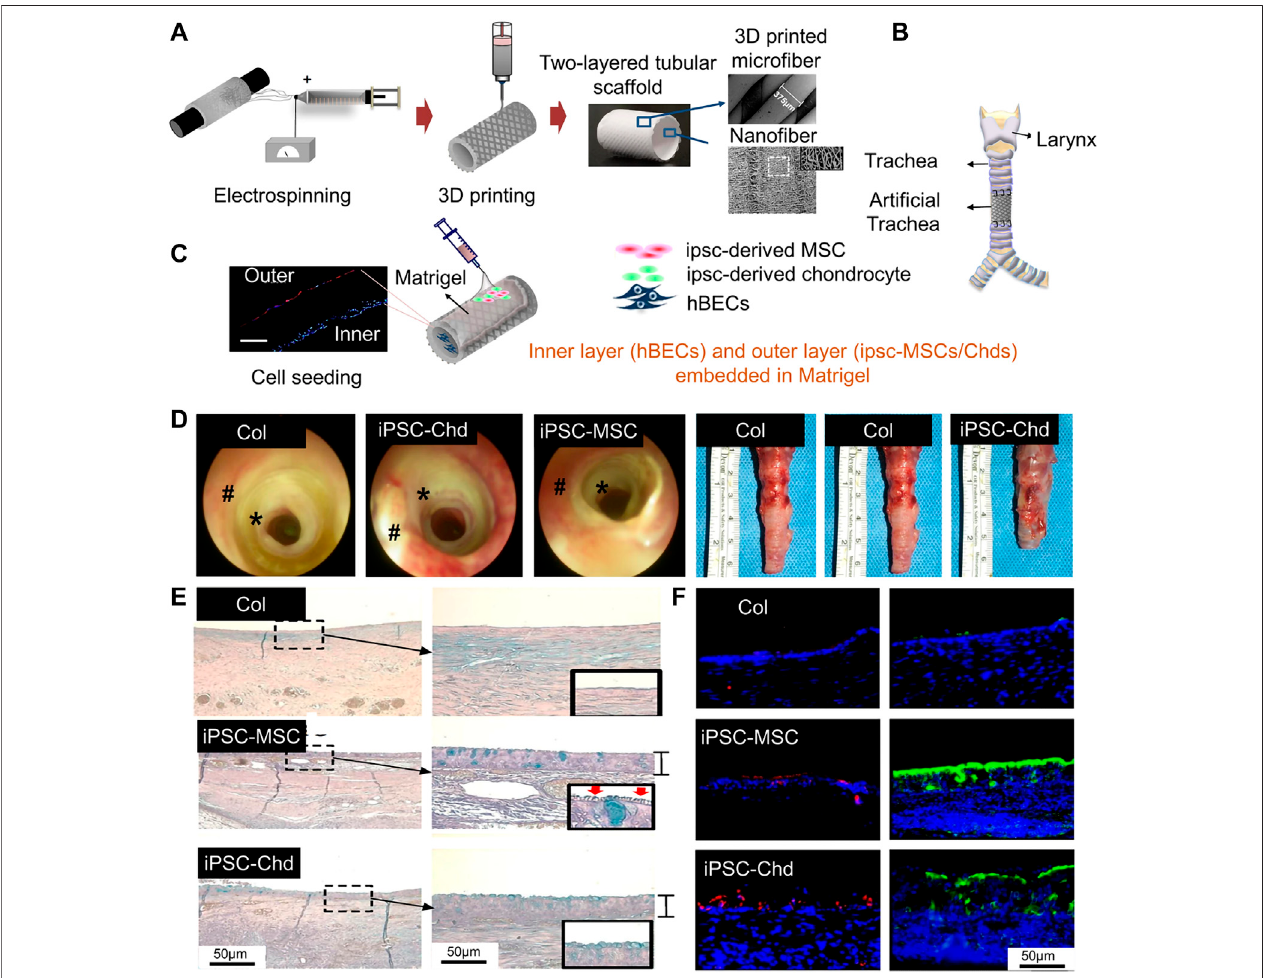
FIGURE 4 | Process diagram for manufacturing a 3D tubular arti fi cial tracheal scaffold. (A) A PCL tubular nano fi ber layer (inner layer) prepared by electrospinning was wrapped with 3D-printed PCL fi ber. (B) Tracheal transplantation and endoscopic analysis. (C) Induced pluripotent stem cell-derived chondrocytes (IPSC-CHDs) andhumanbronchialepithelialcells(hBECs)wereseparatelyseededontheouterandinnerlayersofthescaffold.Eachlayerwasidenti fi edbypkh-26staining(red;IPSC- CHDs) and DAPI (blue; hBECs) staining (scale (cid:2) 200 μ m). (D) The endoscopic images at 4 weeks. (E) Alcian-blue staining showed mucus (blue) generated by regenerated tracheal epithelium 4 weeks after transplantation. (F) Immuno fl uorescence staining for β -tubulin and keratin-5 at the implant site (Kim et al., 2020).